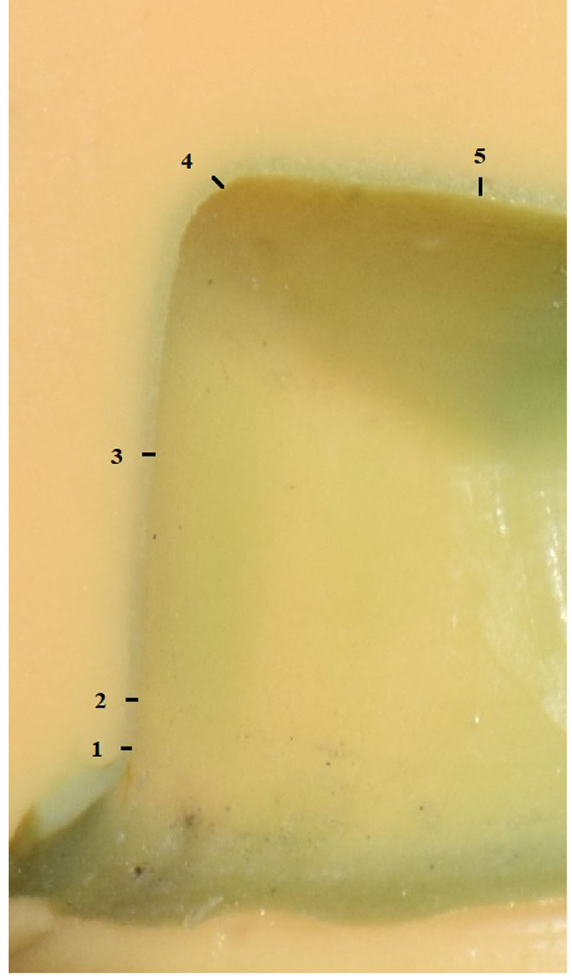
Fig. 2 Internal fi t specimen. Silicon replica specimen with fi ve reference points for surface